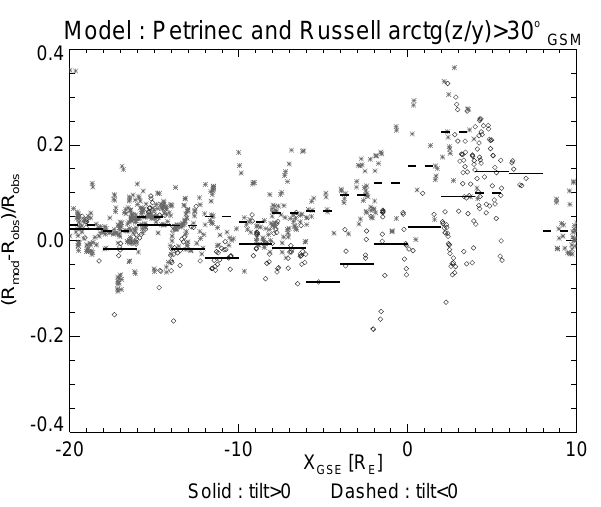
Fig. 4. Comparison of the magnetopause locations for positive (solid line, circles) and negative (dashed line, asterisks) tilt angles at high latitudes.